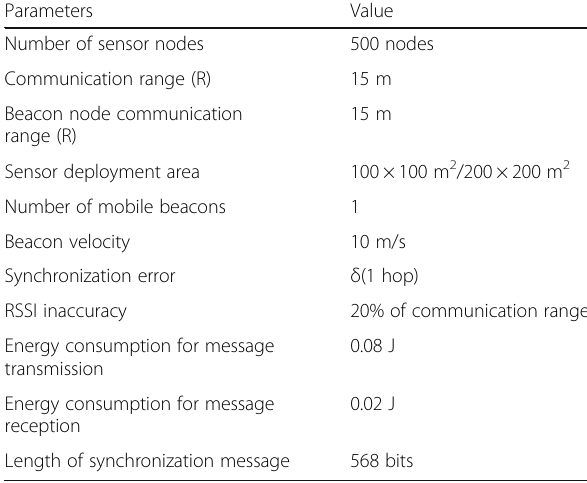
Table 1 Parameters for the experiment